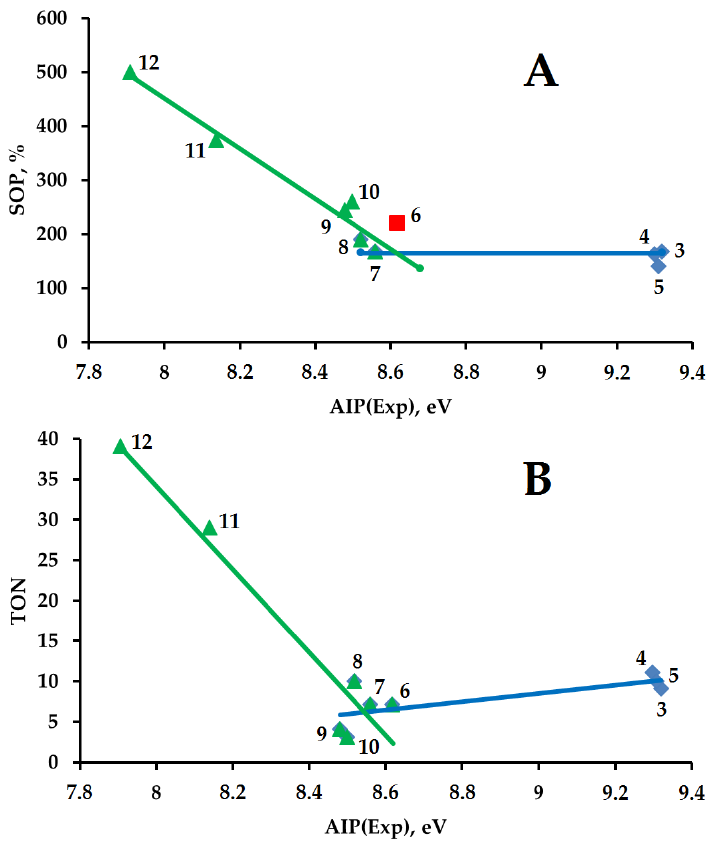
Figure 12. The dependence of the SOP ( A ) and TON ( B ) on the AIP for hydrocarbons 3 – 12 . The points (AIP;SOP) for all RH , except RH 6 (red), are located along two straight lines: SOP = − 466.94AIP + 4188.4, R 2 = 0.9598, for AIP ≤ 8.62 eV (green) and SOP = 164 ± 25 for AIP ≥ 8.62 eV (blue) (Figure 12A). The points (AIP;TON) for all RH are located along two straight lines: TON = − 51.433AIP + 445.66, R 2 = 0.9194, for AIP ≤ 8.54 eV (green) and TON = 5.0703AIP − 37.126, R 2 = 0.4877, for AIP ≥ 8.54 eV (blue) (Figure